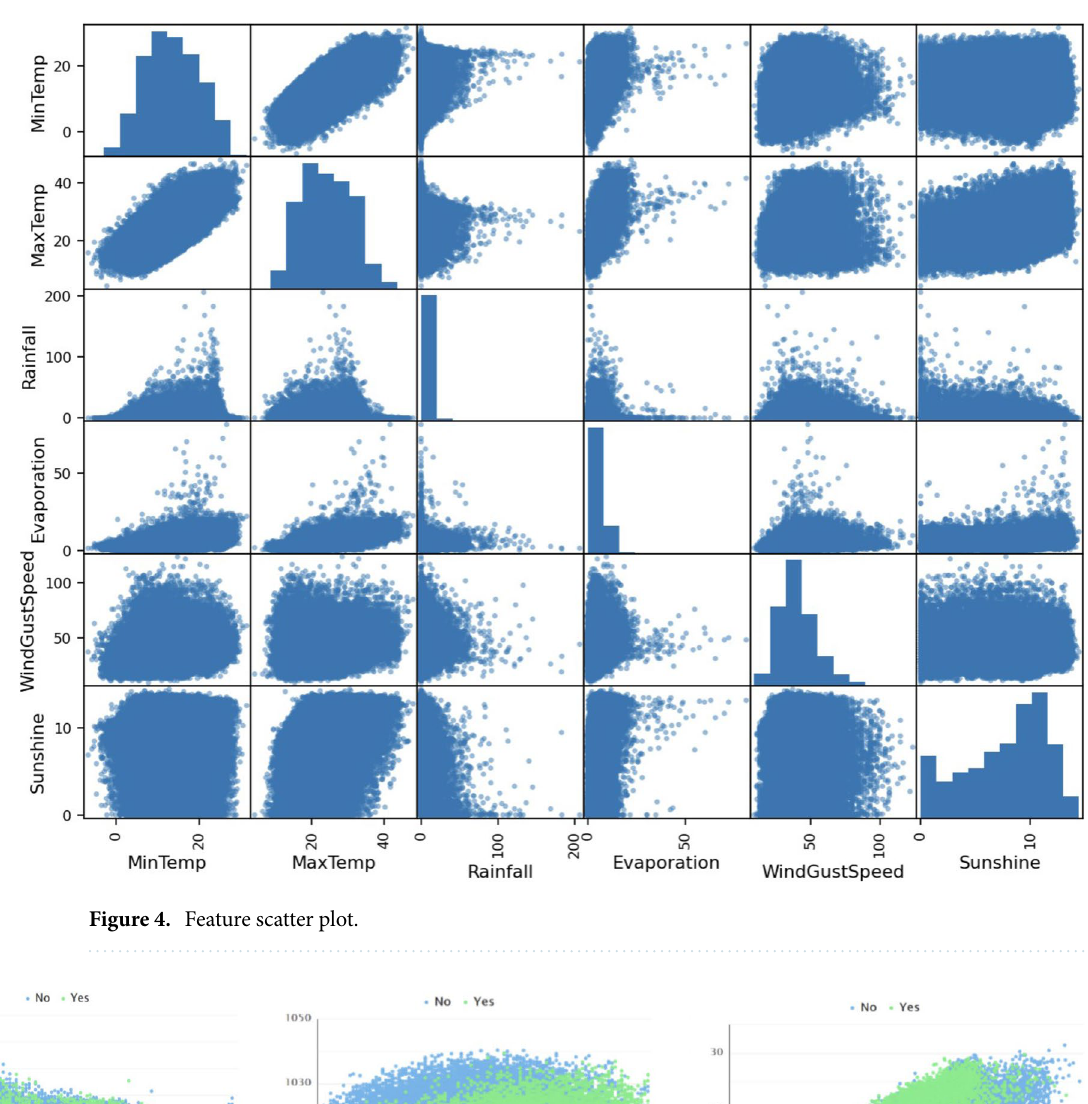
Figure 4. Feature scatter plot.